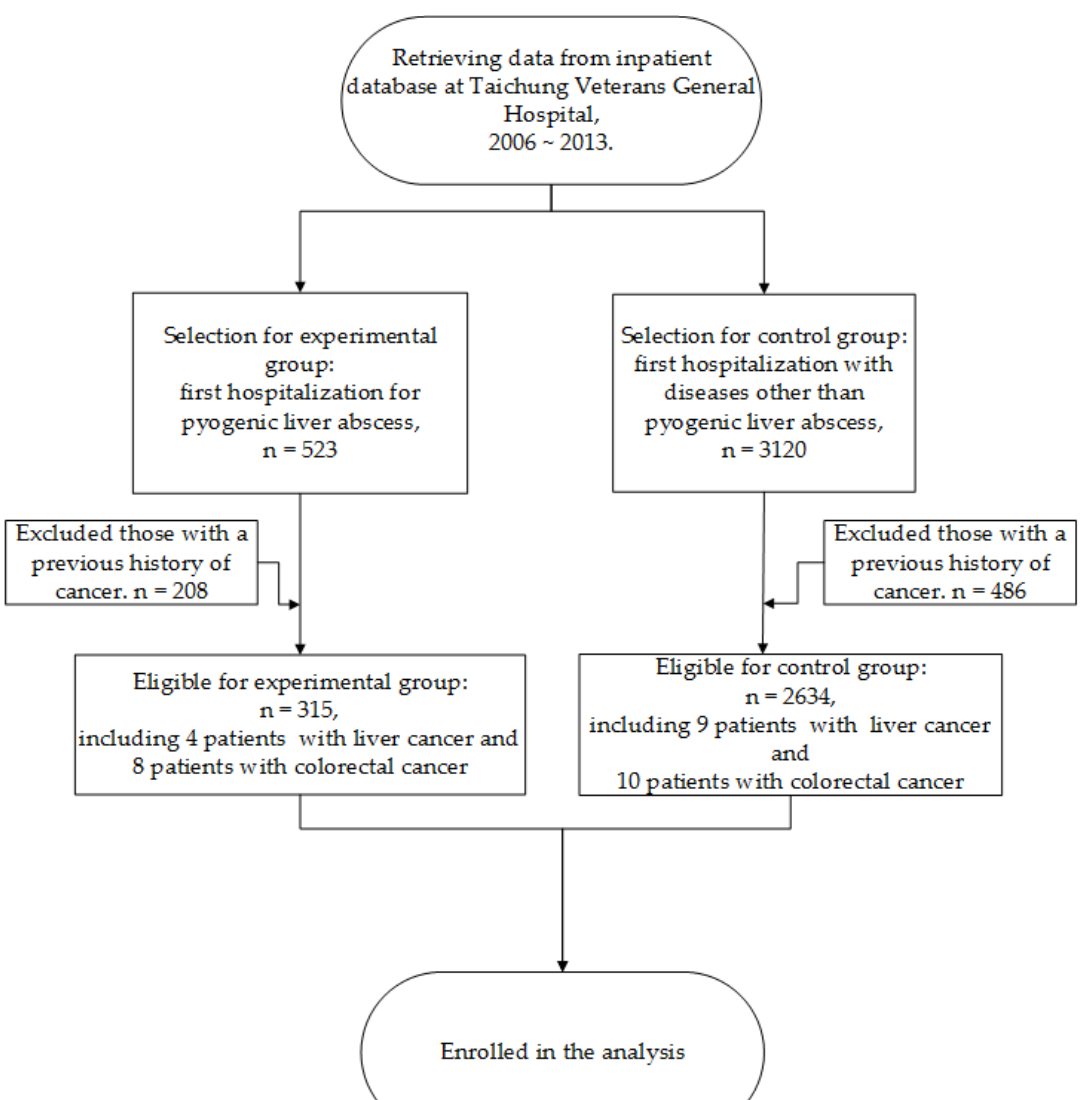
Figure 1. Selection procedure of eligible patients for the analysis.